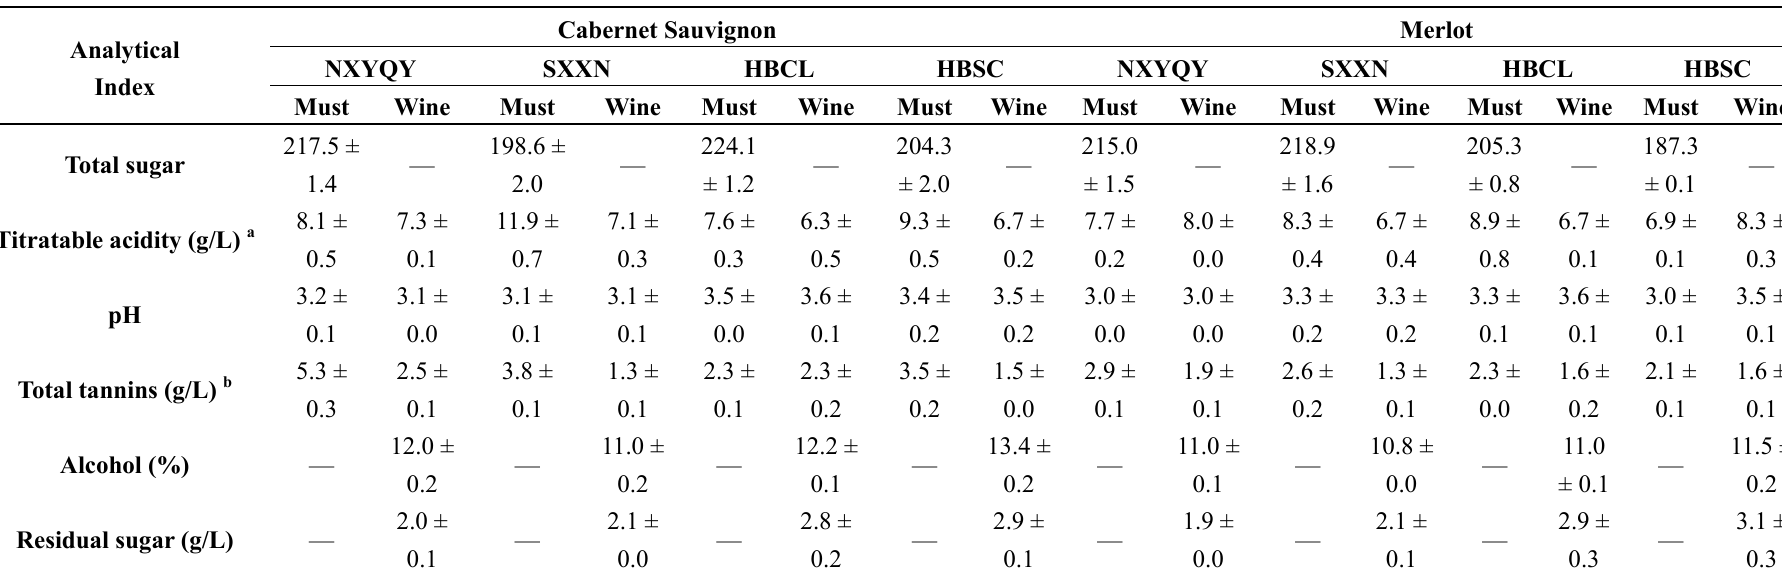
Table 6. General composition of Cabernet Sauvignon and Merlot berries and wines from four different wine grape-growing regions.